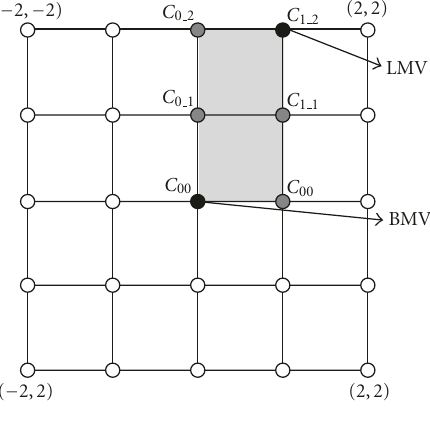
Figure 7: Fast searching pattern using LMV.